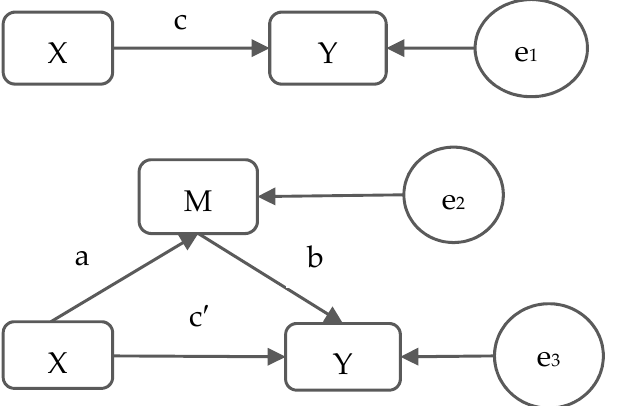
Figure 3. Model of mediation analysis. X means the independent variable (BF(%)), M means the potential mediator (hsCRP or TNF- α ), and Y means the dependent variable (FLD). Association c: association between the independent variable (X) and dependent variable (Y). Association a: association between X and potential mediation variable (M). Association b: association between M and Y after controlling for X. Association c ′ : association between X and Y after controlling for M.